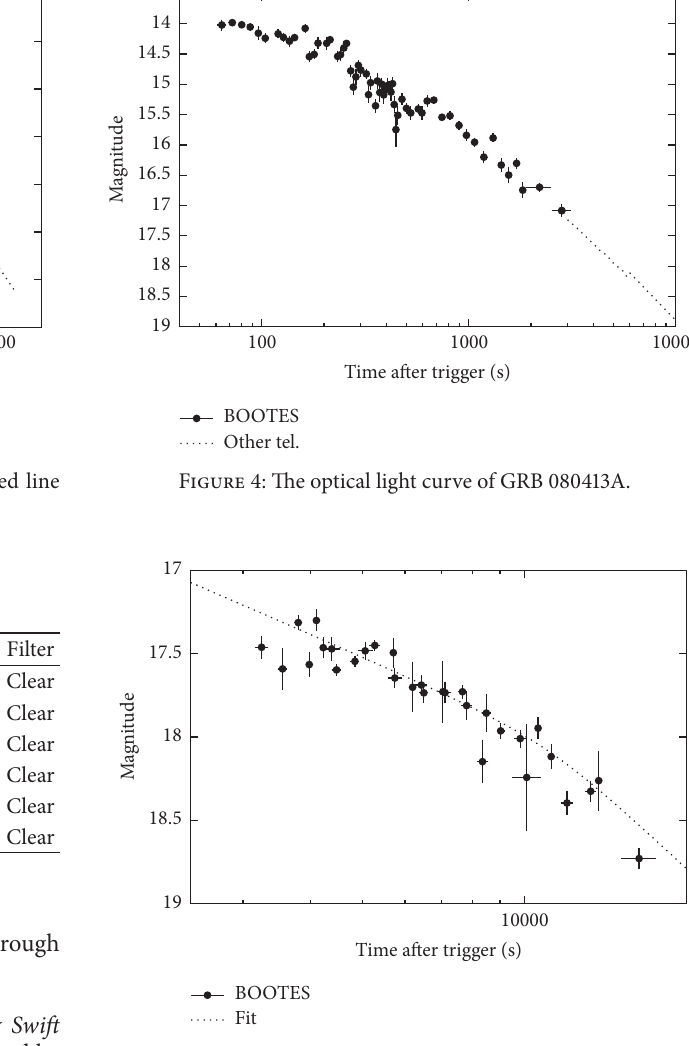
Figure 5: The optical light curve of GRB 080603B